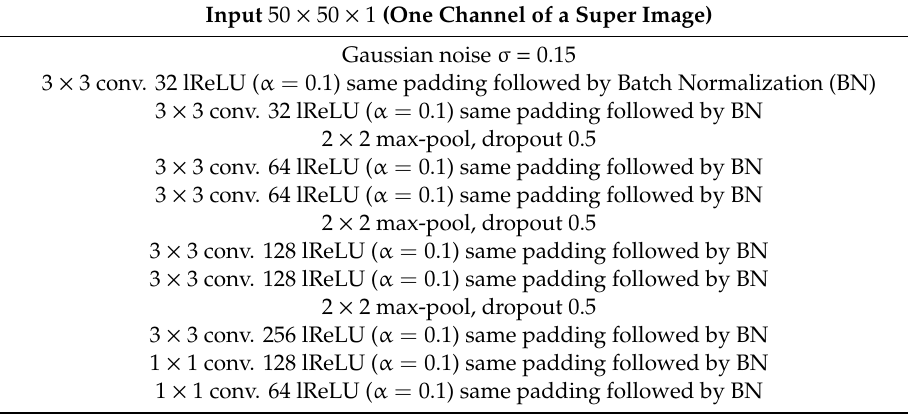
Table A1. Architecture of the convolutional based layers.